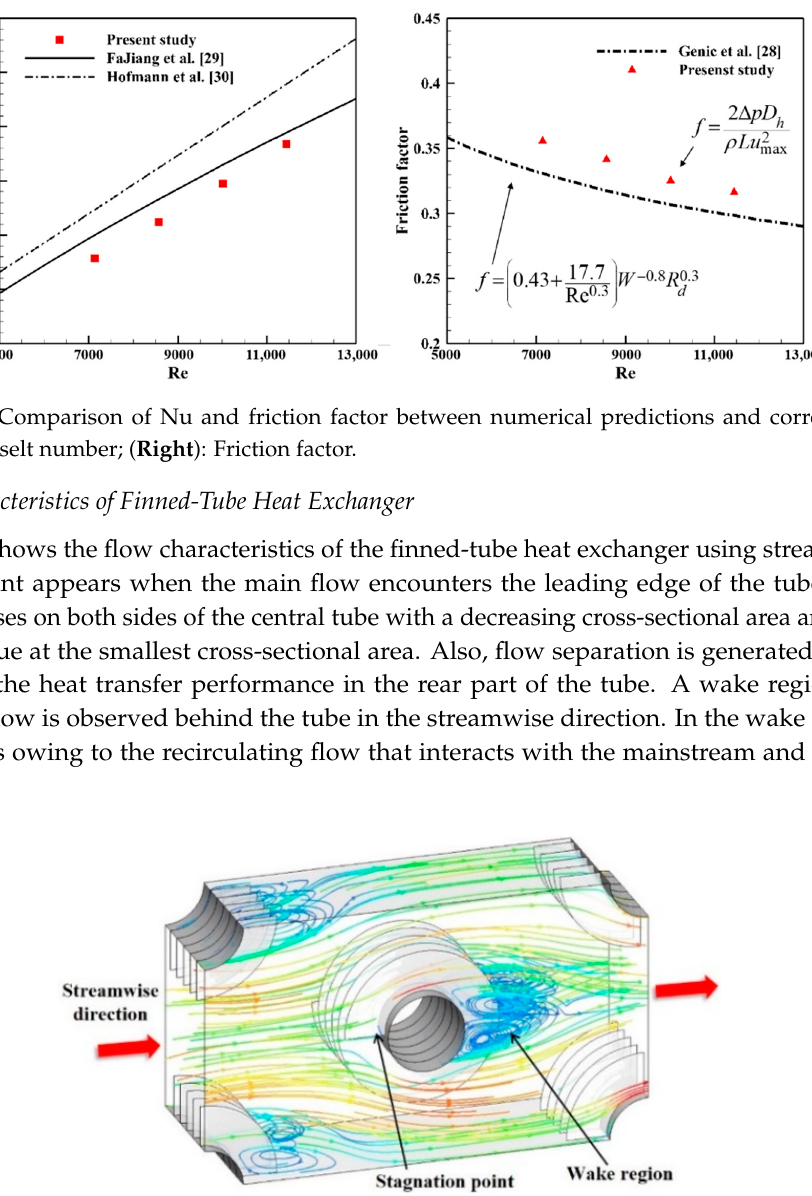
Figure 5. Flow characteristics of the spiral finned ‐ tube heat exchanger.